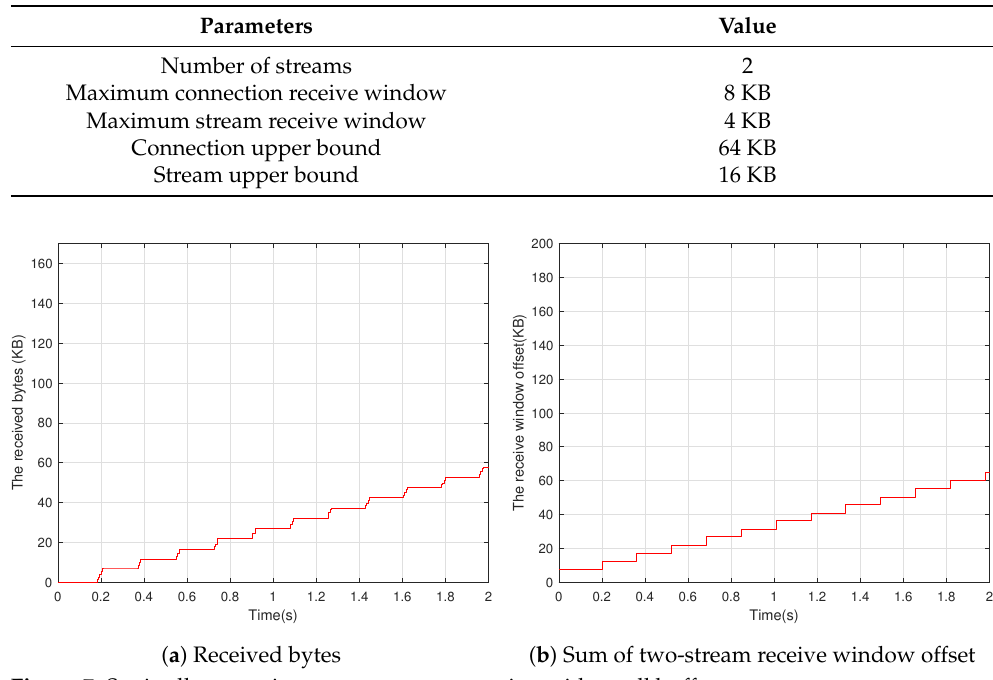
Figure 7. Static allowance in a two-stream connection with small